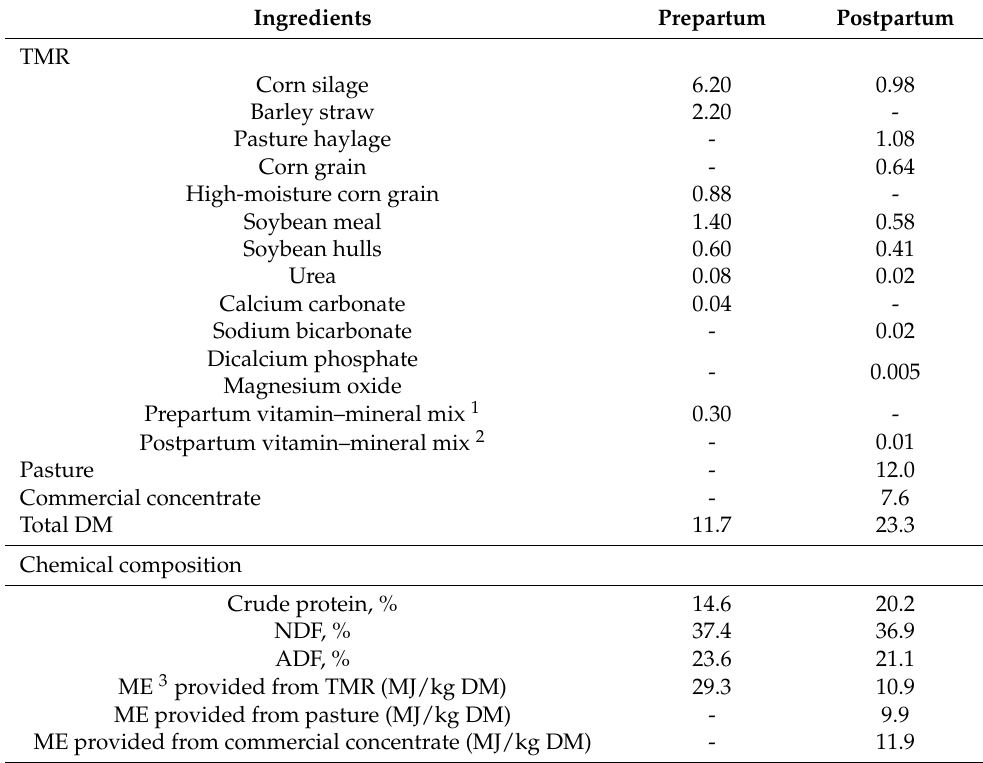
Table 1. Ingredients (mean of kg DM/cow/d), chemical composition (% of total kg DM), and metabolizable energy (ME) of the total mixed ration (TMR), pasture, and concentrate offered during prepartum and postpartum periods to Holstein cows in an automatic milking system. Ingredients Prepartum